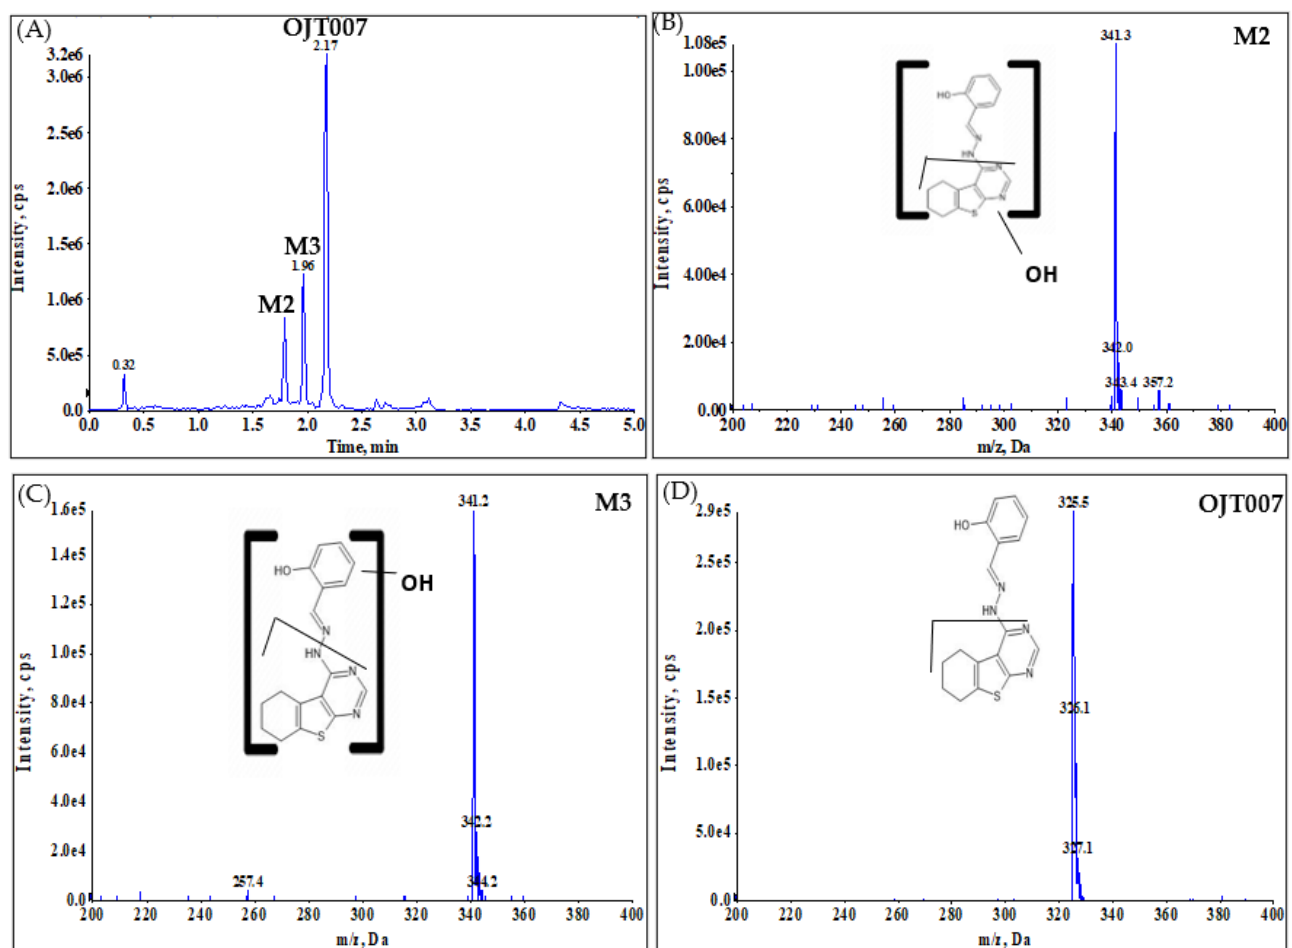
Molecules 2022 , 27 , x FOR PEER REVIEW 6 of 18 Figure 4. ( A ) Neutral loss (NL) of 120 Da Chromatogram ( B ) Spectra for M2 (retention time: 1.76 min) (M2). ( C ) Spectra for OJT007 (retention time: 2.18 min). A NL scan (Figure 5) was then performed for 136 Da (120 plus 16) to screen for me- tabolites obtained by hydroxylation on the neutral fragment. Neutral loss scan evidenced three peaks eluting at 1.76, 1.96, and 2.17 min. NL spectra for the peaks eluting at 1.76 (Figure 5B) and 1.96 (Figure 5C) showed ions with m/z 341, which is 16 Da higher than the addition ion of OJT007, confirming both peaks as metabolites. Furthermore, the neu- tral loss scan suggests that oxidation for the metabolite eluting at 1.96 occurs in the phenol portion of the molecule. It is possible that the same neutral loss that produced the peak at 2.17 min (parent molecule), gave rise to the peak eluting at 1.76 min.